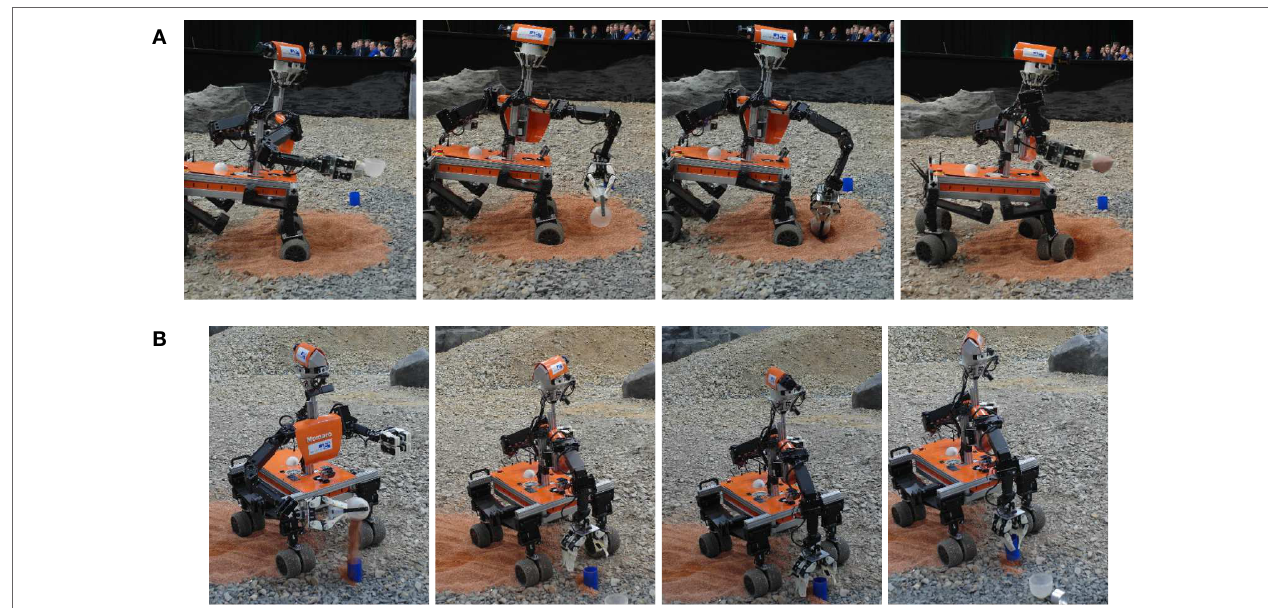
FIGURE 2 | Manipulation capabilities . (A) Momaro is using a scoop to take a soil sample. (B) After filling the blue cup with previously scooped soil, Momaro discards the scoop and grasps the cup to deliver it to a base